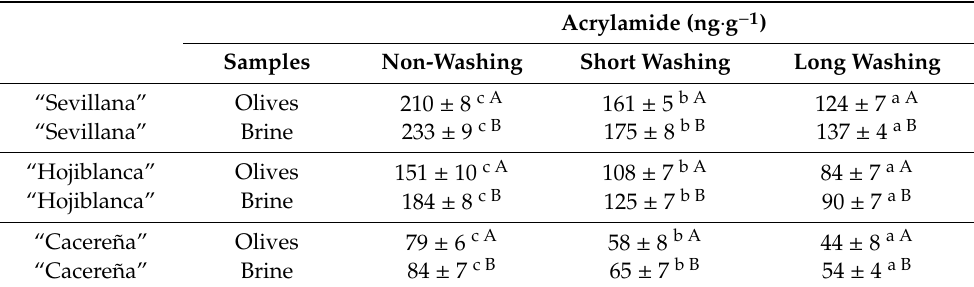
Table 1. Acrylamide content (ng · g − 1 ) of olives and brine after submitting olives to washing (non-washing, washing in water at 25 ◦ C for 45 min (short washing), and washing in water at 25 ◦ C for 2 h (long washing) after the sterilization process. Results are expressed as mean ± SD of five sample replicates. Superscript in the same row indicates statistically significant differences between washing processes (Tukey test, p < 0.05). Different capital letters in the same columns indicate statistically significant differences between olives and brine in each treatment (Tukey test, p <